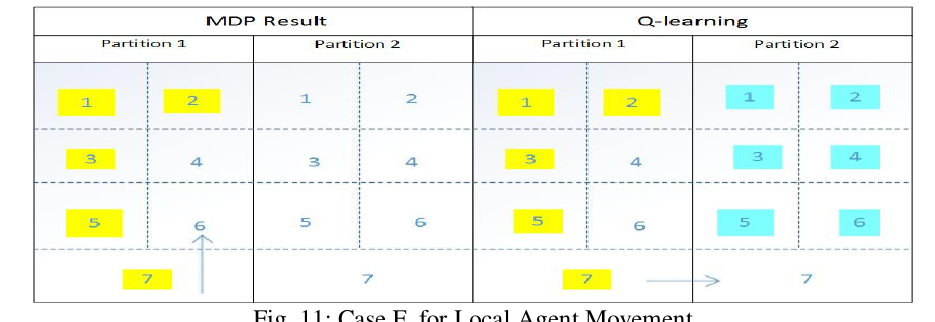
Fig. 11: Case F for Local Agent Movement